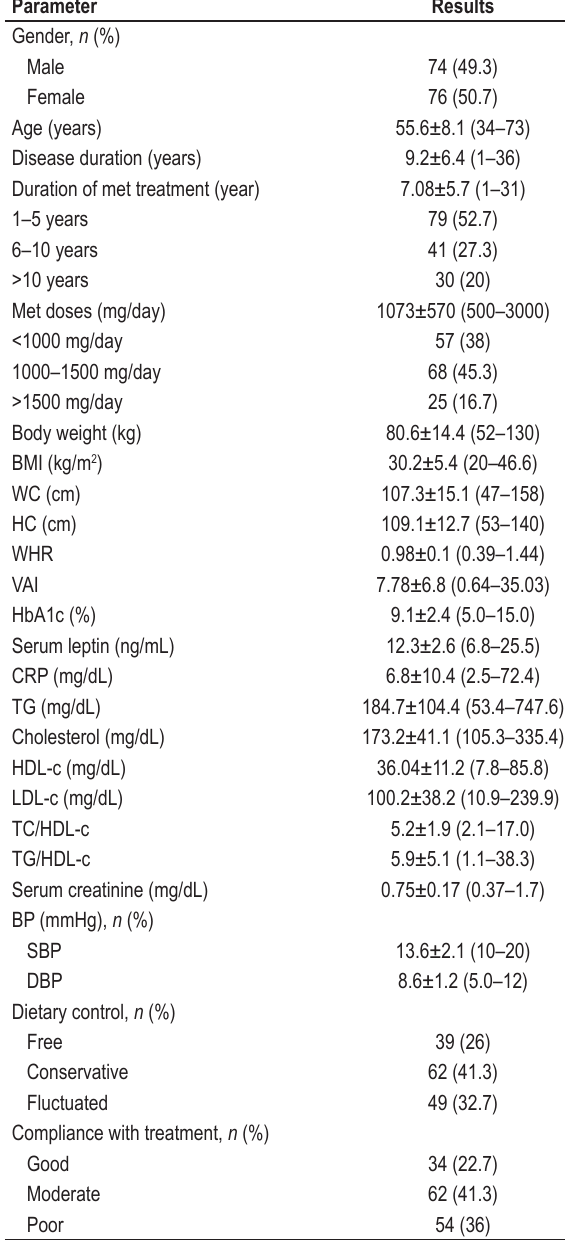
TABLE 1. Patients characteristics and demographic data ( n =150)